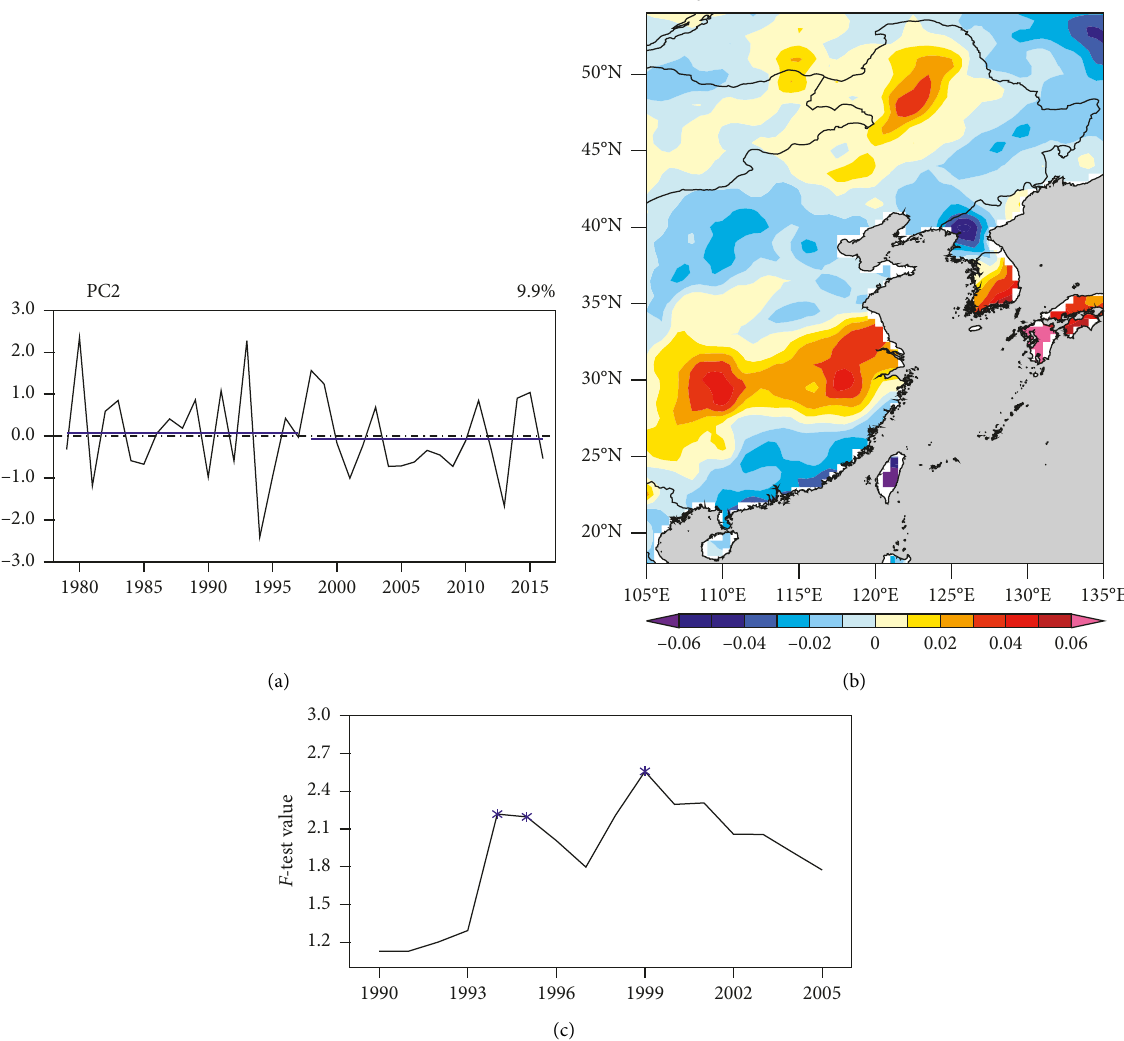
Figure 3: Normalized PC2 time series of the summer mean precipitation efficiency in East Asia during 1979–2016 (a), spatial distribution of EOF2 (b), and analysis of variance on PC2 variability (c). The percentage value at the top right in (a) denotes the explained variance of EOF2. Blue solid lines in (a) represent the abrupt change in mean value between 1979–1997 and 1998–2016, and the dashed line is the zero baseline. Significant PC2 variabilities in (c) are marked with blue